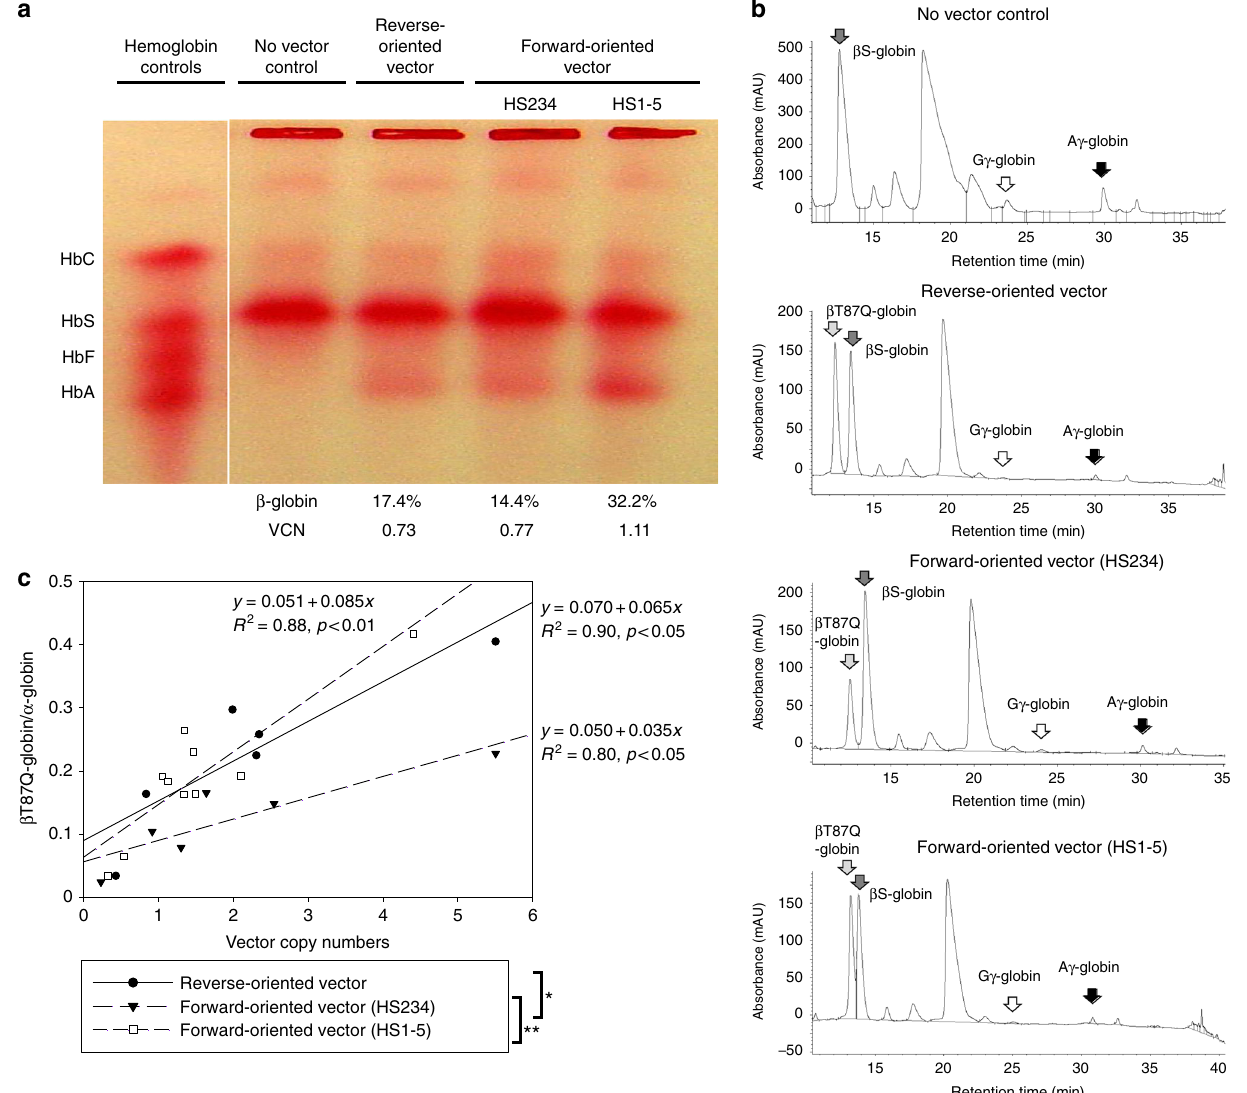
Fig. 6 Robust β -globin production at the protein level with the forward-oriented β -globin vector in erythroid cells differentiated from plerixafor-mobilized CD34 + cells in SCD. a SCD CD34 + cells were transduced with the optimized forward-oriented β -globin (or β T87Q-globin including an anti-sickling mutation T87Q) vectors at MOI 50 and the transduced cells were differentiated into erythroid cells for 2 weeks. β -globin production was evaluated by hemoglobin electrophoresis (HbA bands) and/or RP-HPLC (%), and VCNs were evaluated by quantitative PCR. b Globin protein peaks were detected by RP-HPLC. c Globin-expression levels per vector were evaluated by regression lines between VCNs and β T87Q-globin amounts at the protein level. The β T87Q-globin amounts were calculated by the area under the curve in RP-HPLC, compared with α -globin. ** p < 0.01 and * p < 0.05 evaluated by Tukey ’ s HSD test among regression lines. All globin protein analysis experiments were performed in a single